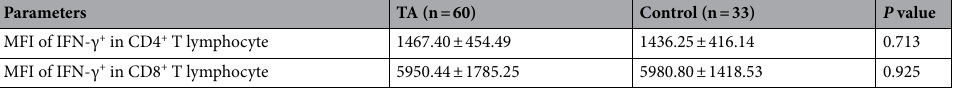
Table 3. Comparison MFI of IFN-γ + in T lymphocyte between TAK patients and control